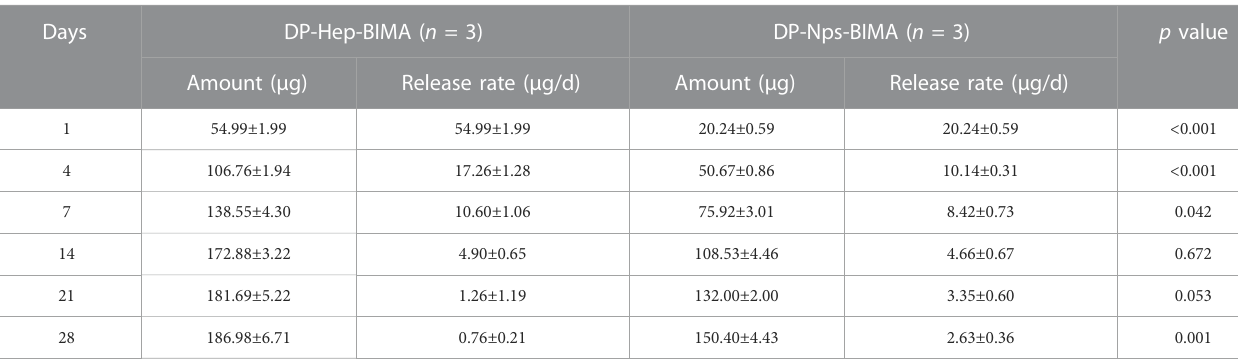
TABLE 1 In vitro release assay of